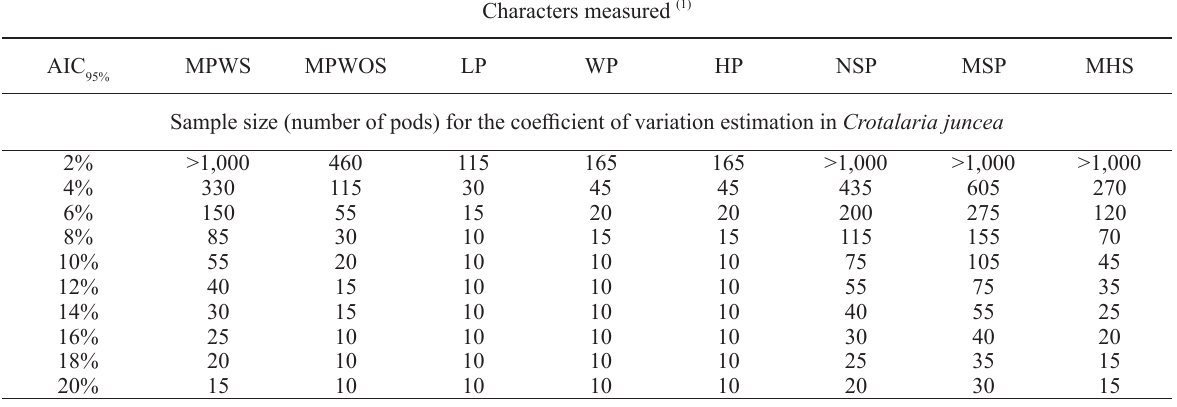
Sample size (number of pods) by resampling with replacement, to estimate the coefficient of variation of eight characters measured in four species of crotalarias - C. juncea , C. spectabilis , C. breviflora and C. ochroleuca - in the season of 2014/15, for the amplitudes of the confidence interval of 95% (ACI ) equal to 2%, 4%, ..., 20%. 95% Characters measured (1)